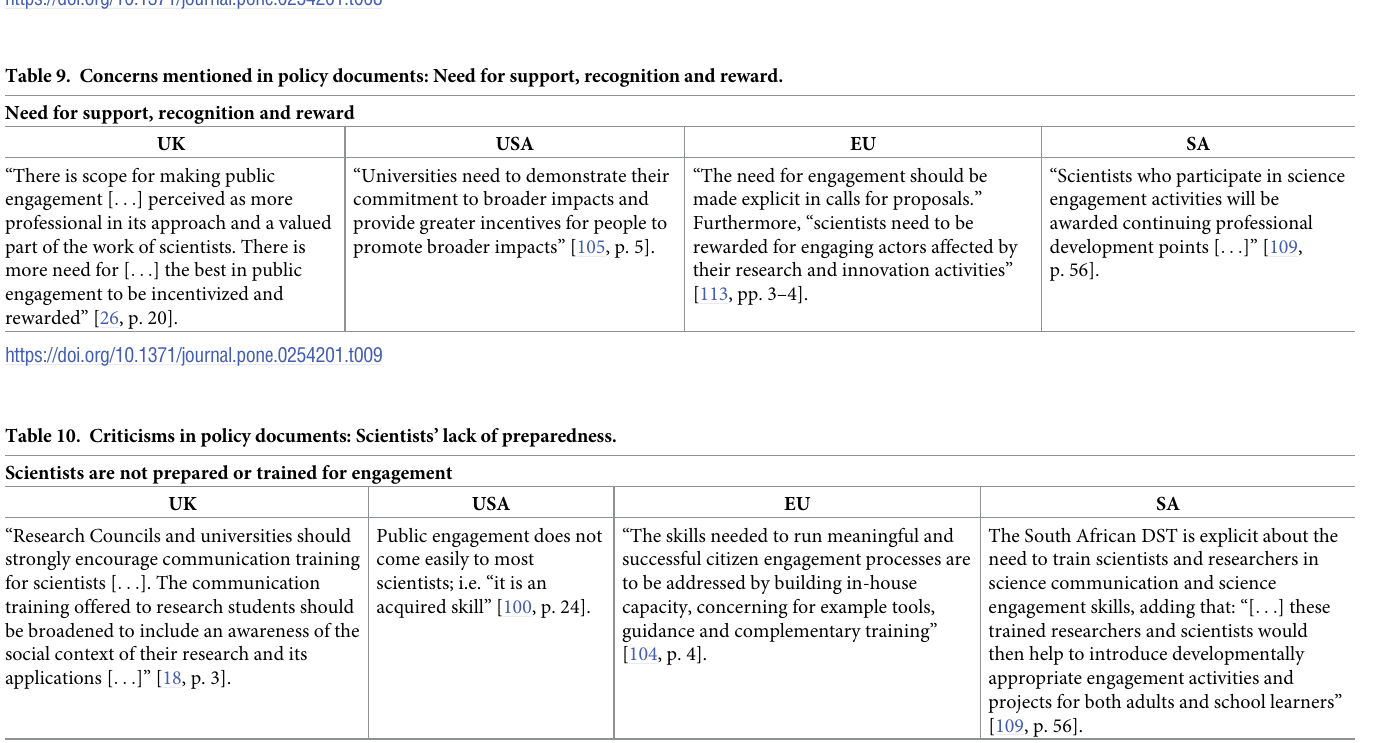
Table 9. Concerns mentioned in policy documents: Need for support, recognition and reward. Need for support, recognition and reward UK USA EU SA “There is scope for making public engagement [ ... ] perceived as more professional in its approach and a valued part of the work of scientists. There is